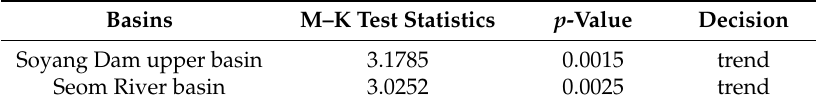
Table 1. Results of the Mann–Kendall trend test in the two basins. Basins